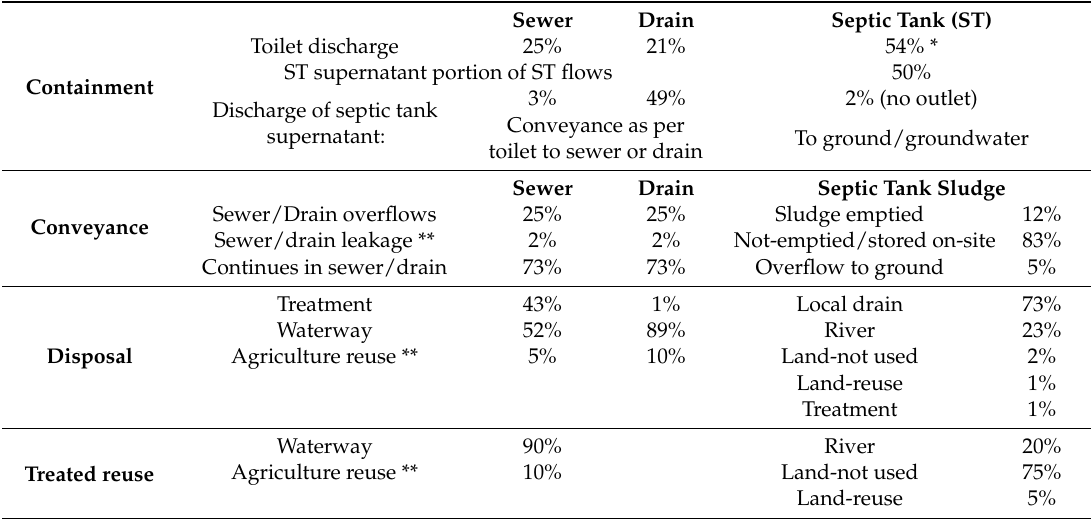
Table 2. Inputs to model for Dhaka (Bangladesh) base